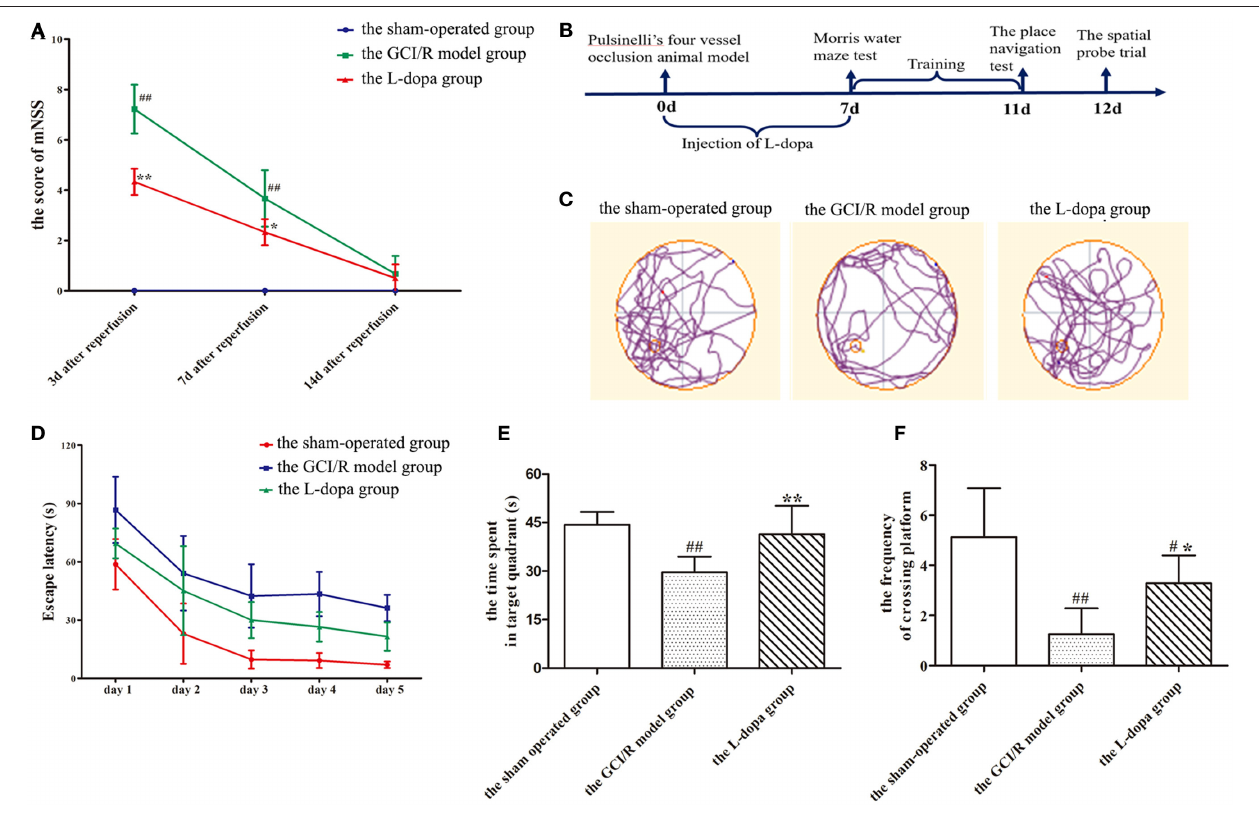
FIGURE 1 | Levodopa improves cognitive impairment after GCI/R injury. (A) mNSS of the rats at 3, 7, and 14 days after GCI/R injury in each group. (B) Experimental timeline for Morris water maze. Administration of levodopa 7 consecutive days after GCI/R injury produces learning and memory recovery in rats as assessed in Morris water maze. Each rat received three training trials per day for 5 consecutive days. On the 11th day, the place navigation was carried out. Next day, the platform was removed for spatial probe trial. (C) Swimming paths of the rats in each group during the Morris water maze. (D) The escape latency during the training period of 5 consecutive days. (E) The time spent in target quadrant. (F) The frequency of crossing platform. Data are shown as means ± SD. ## p < 0.01 vs. the sham-operated group, ** p < 0.01 vs. the GCI/R model group. # p < 0.05 vs. the sham-operated group, * p < 0.05 vs. the GCI/R model